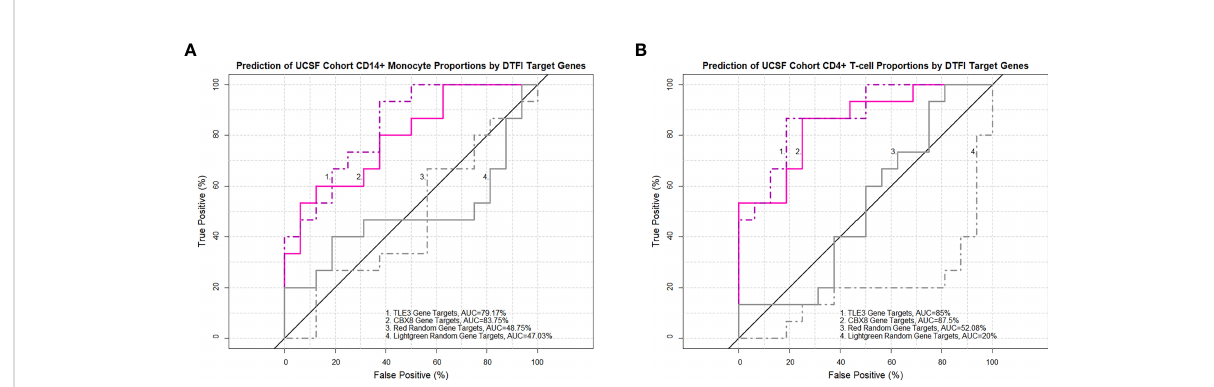
FIGURE 8 TLE3 and CBX8 target gene expression in MAM predicts imputed monocyte and lymphocyte proportions in the UCSF cohort. Receiver operating characteristic (ROC) curves demonstrate the area under the curve (AUC) as a measure of predictive performance for signi fi cant partial least squares discriminant analysis (PLS-DA) models in the validation cohort and negative controls derived from non-preserved modules (red and lightgreen) between ACCESS and UCSF cohorts. Predictive accuracy of CD14+ monocyte proportions (A) and CD4+ T-cell proportions (B) was signi fi cantly greater with TLE3 and CBX8 target genes in comparison to both negative control models (p-value < 0.05; Venkatraman test for AUC comparison with 10,000